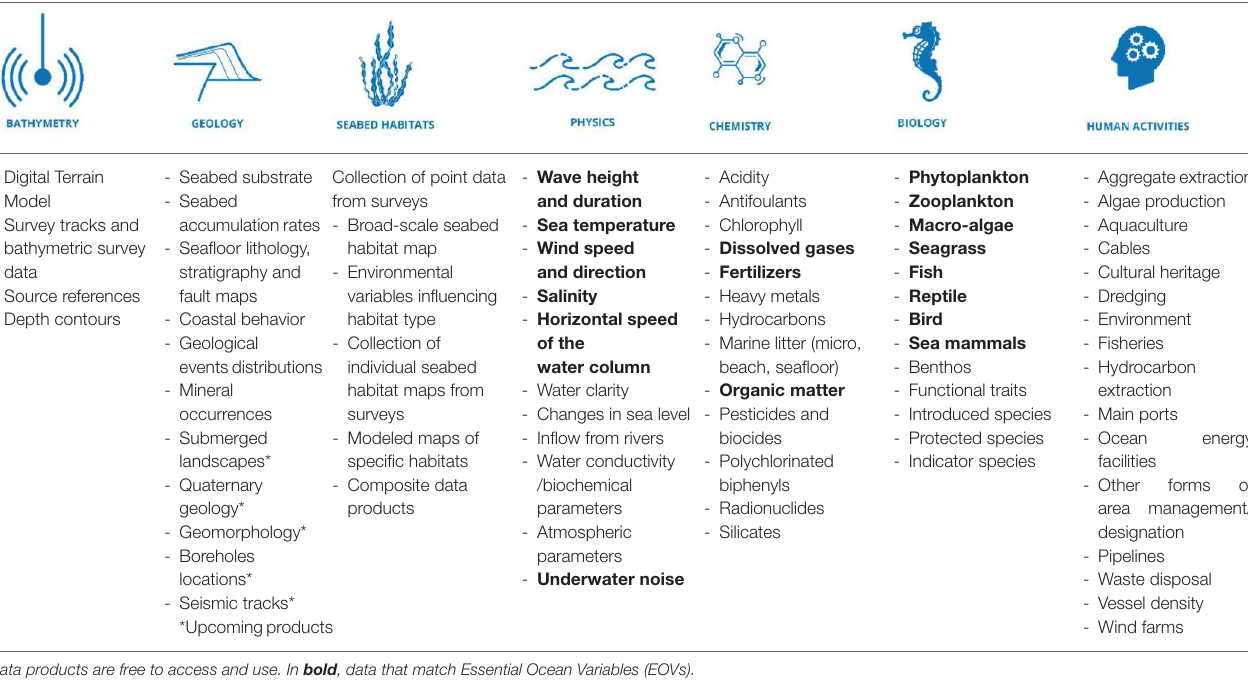
TABLE 2 | Thematic coverage provided by the data and products available through the EMODnet thematic portals.